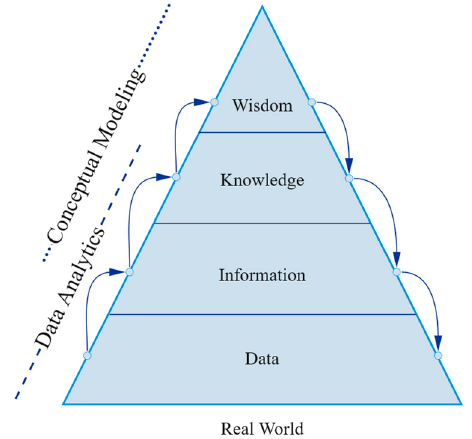
Figure 2. DIKW Pyramid with Conceptual Modeling and Data Analytics.